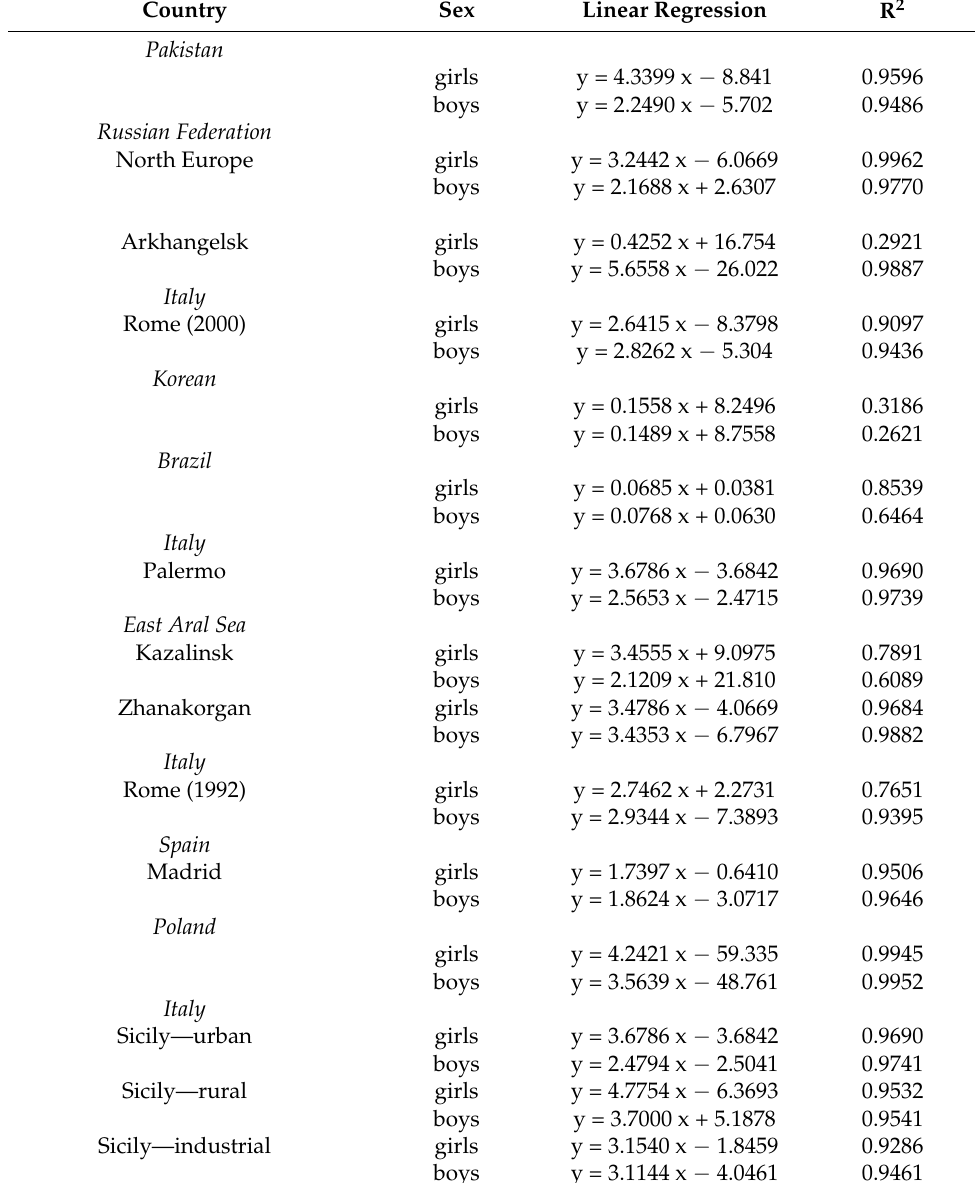
Table 6. Linear regression and coefficient of determination (R 2 ) between our data and each dataset for different girl teenagers hair determined worldwide